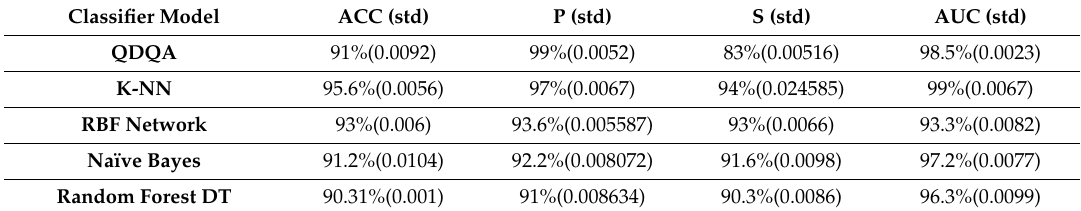
Table 3. Metrics for feature subset 6, which has the highest classification